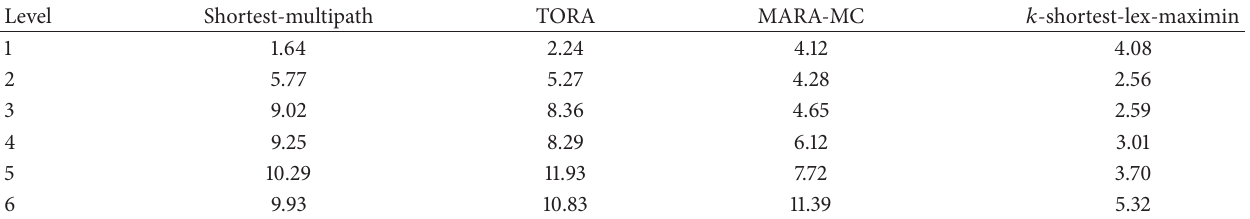
Table 2: Comparison of four tested algorithms: average variance in numbers of paths per node at different levels 1–6 for 50-node networks.